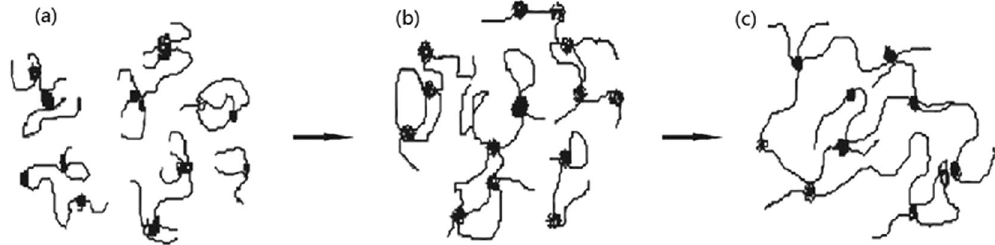
Figure 9. Schematic of the intermolecular association behavior of a BD-HMHEC solution with increasing